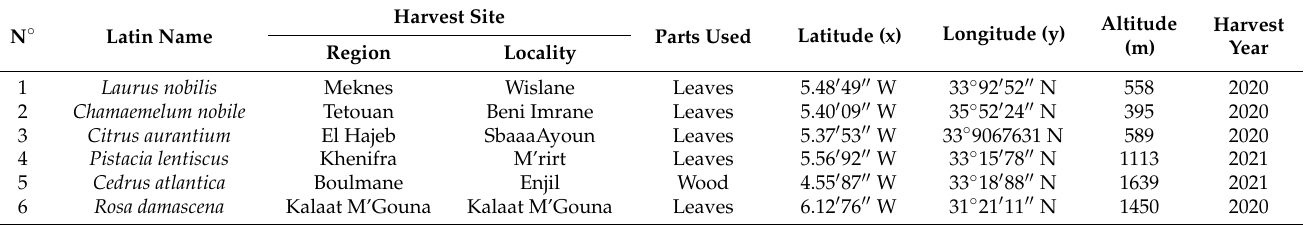
Table 16. Distribution of individuals in the plant species studied and their harvest sites by